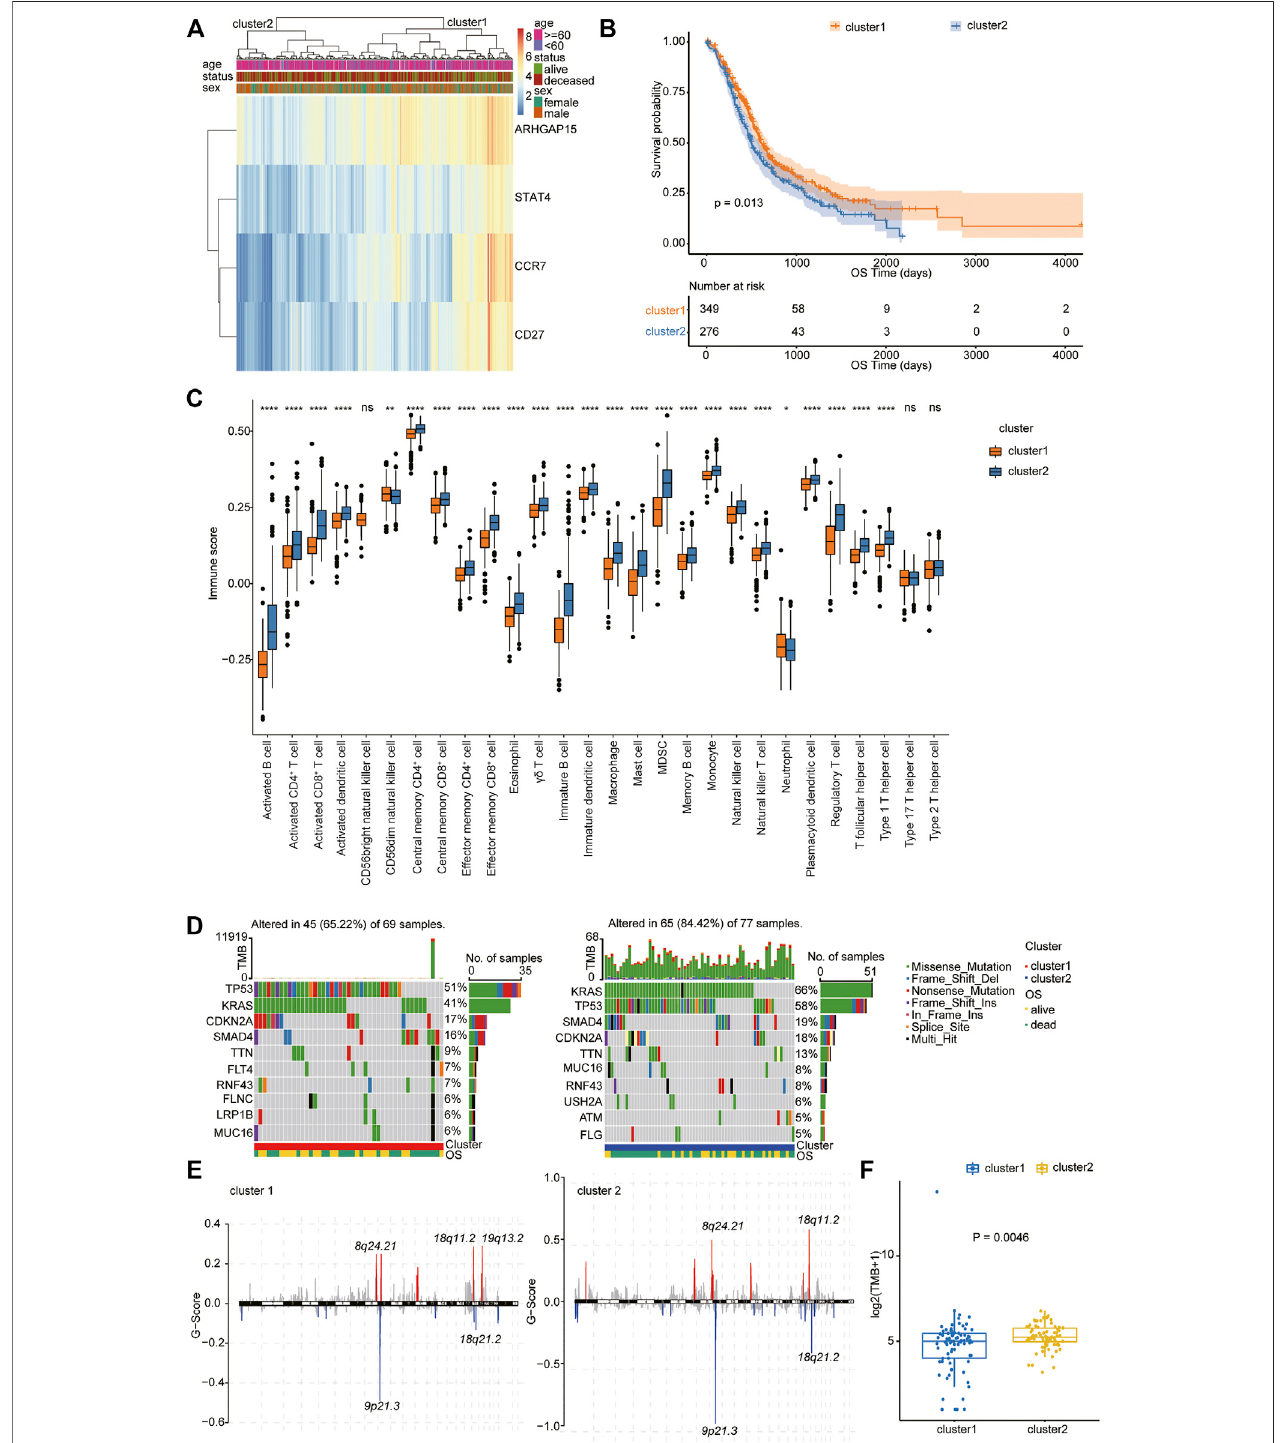
FIGURE 4 | Molecular subtype identi fi cation according to the Type 1 T helper cell – related gene signature. (A) A hierarchical clustering based on four characteristic genes. (B) Kaplan – Meier curves for the OS of PDAC patients between clusters 1 and 2 in the TCGA, PACA-AU, and PACA-CA cohorts. (C) The proportion of immune cell in fi ltration between different clusters. (D – E) Distribution of gene mutations (D) and missing copies (E) between clusters 1 and 2 are shown, and tumor mutation burden is compared using Student ’ s t -test. Abbreviations: OS, overall survival; PDAC, pancreatic ductal adenocarcinoma; TCGA, The Cancer Genome Atlas; TMB, tumor mutation burden.